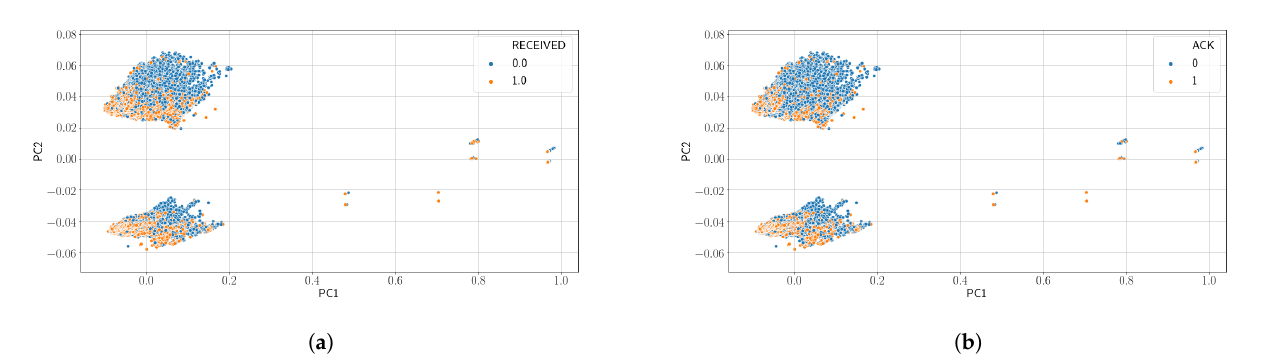
Figure 5. Results from Principal Component Analysis (PCA). ( a ) Using no feedback and I gw as label (Case A) and ( b ) using no feedback and I ack as label (Case